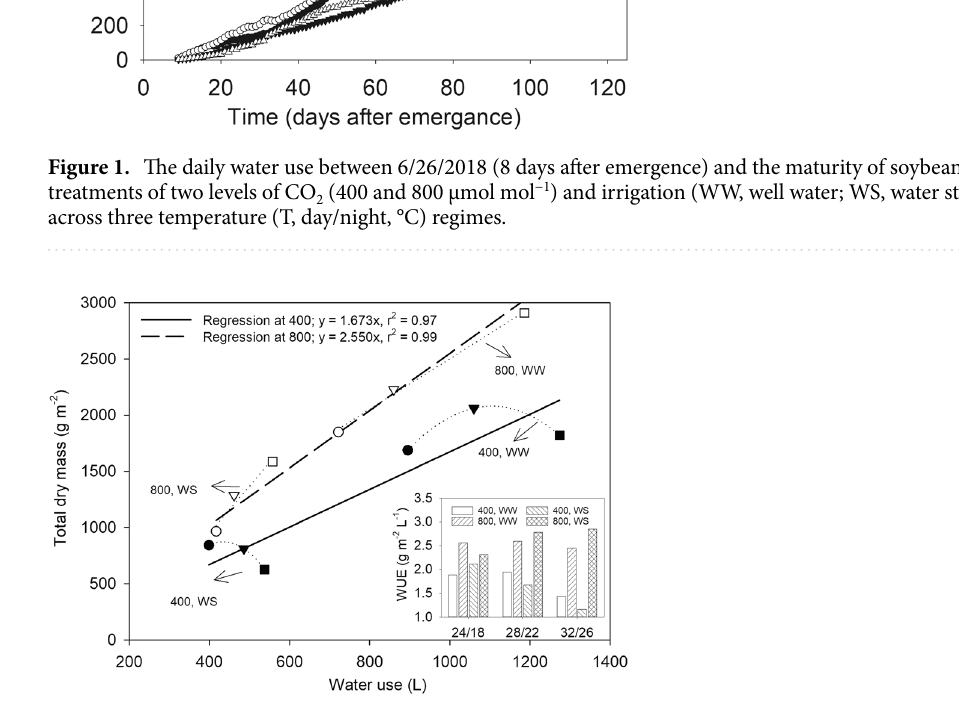
Figure 2. The total dry mass production (sum of the three harvests) as a function of the total water use over the growing period. The solid and dashed lines show the linear regression across temperature and irrigation treatments for two CO 2 levels separately. The dotted lines show either the polynomial 2nd order regression fit at ambient CO 2 or linear fit at elevated CO 2 for each irrigation treatment across the three day/night temperature regimes (circle, 24/18; triangle, 28/22; square 32/26 °C). Filled and unfilled symbols represent the ambient and elevated CO 2 , respectively. The bar graph at the lower right corner shows the water use efficiency (WUE, g dry mass m −2 L −1 of water) as influenced by CO 2 levels (400 and 800 µmol mol −1 ) and irrigation (WW, well water; WS, water stress) under three temperature (T, day/night, °C) regimes. WUE was calculated as the ratio between total dry mass and water